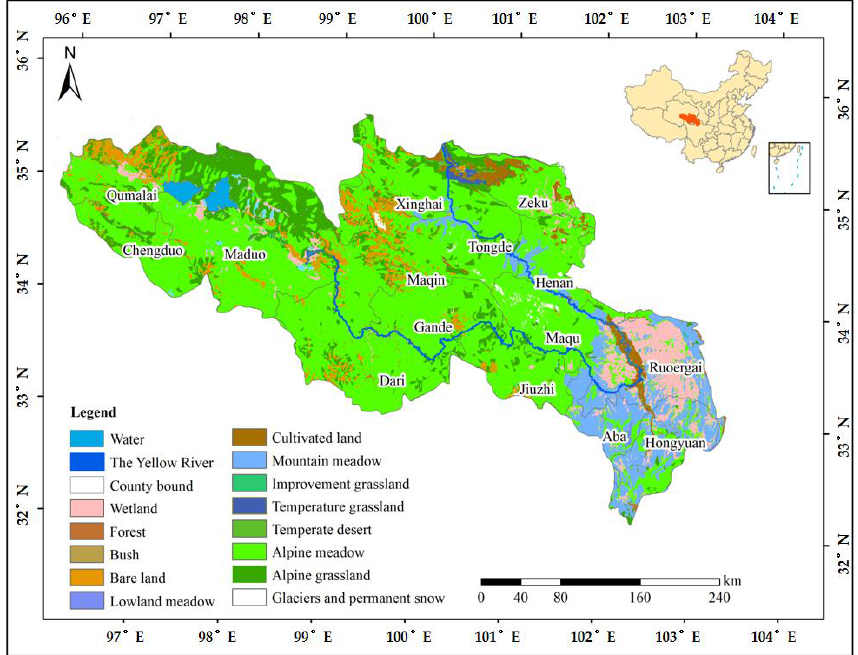
Figure 1. Location of the HRY, grassland types and county locations.